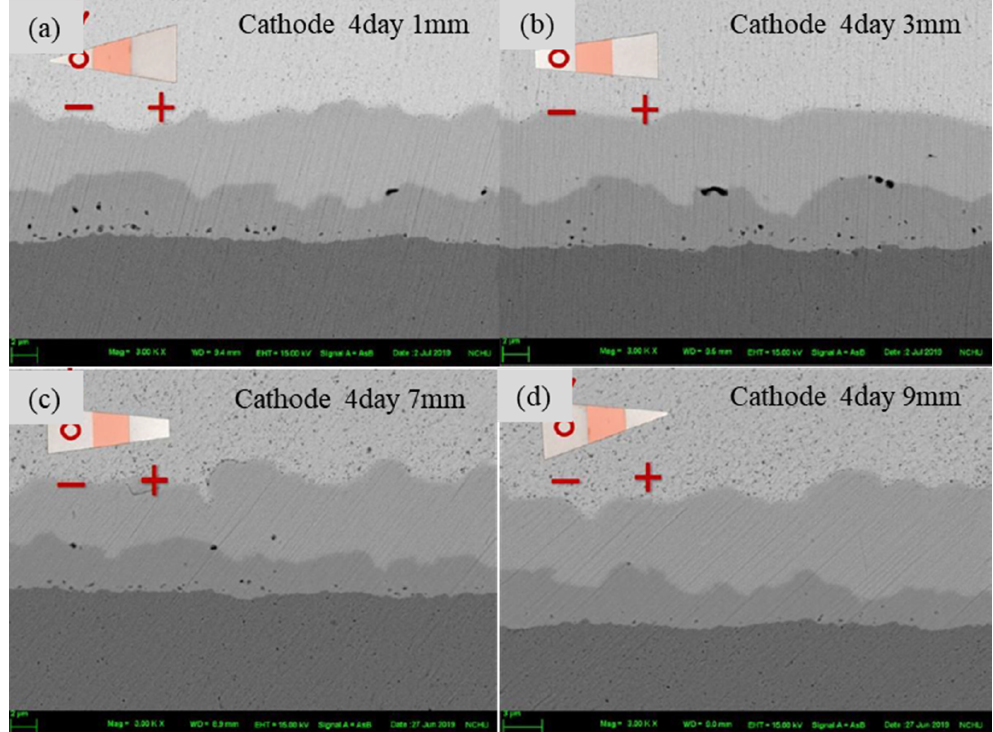
Figure 14. SEM images of various samples heated at 180 °C and subjected to a current of 0.8 A after 4 days. ( a ) Cathode ends (indicated on red circle) on the 1 mm side of 1:9 sample; ( b ) Cathode ends (indicated on red circle) on the 3 mm side of 3:7 sample; ( c ) Cathode ends (indicated on red circle) on the 7 mm side of 3:7 sample; ( d ) Cathode ends (indicated on red circle) on the 9 mm side of 1:9 sample.